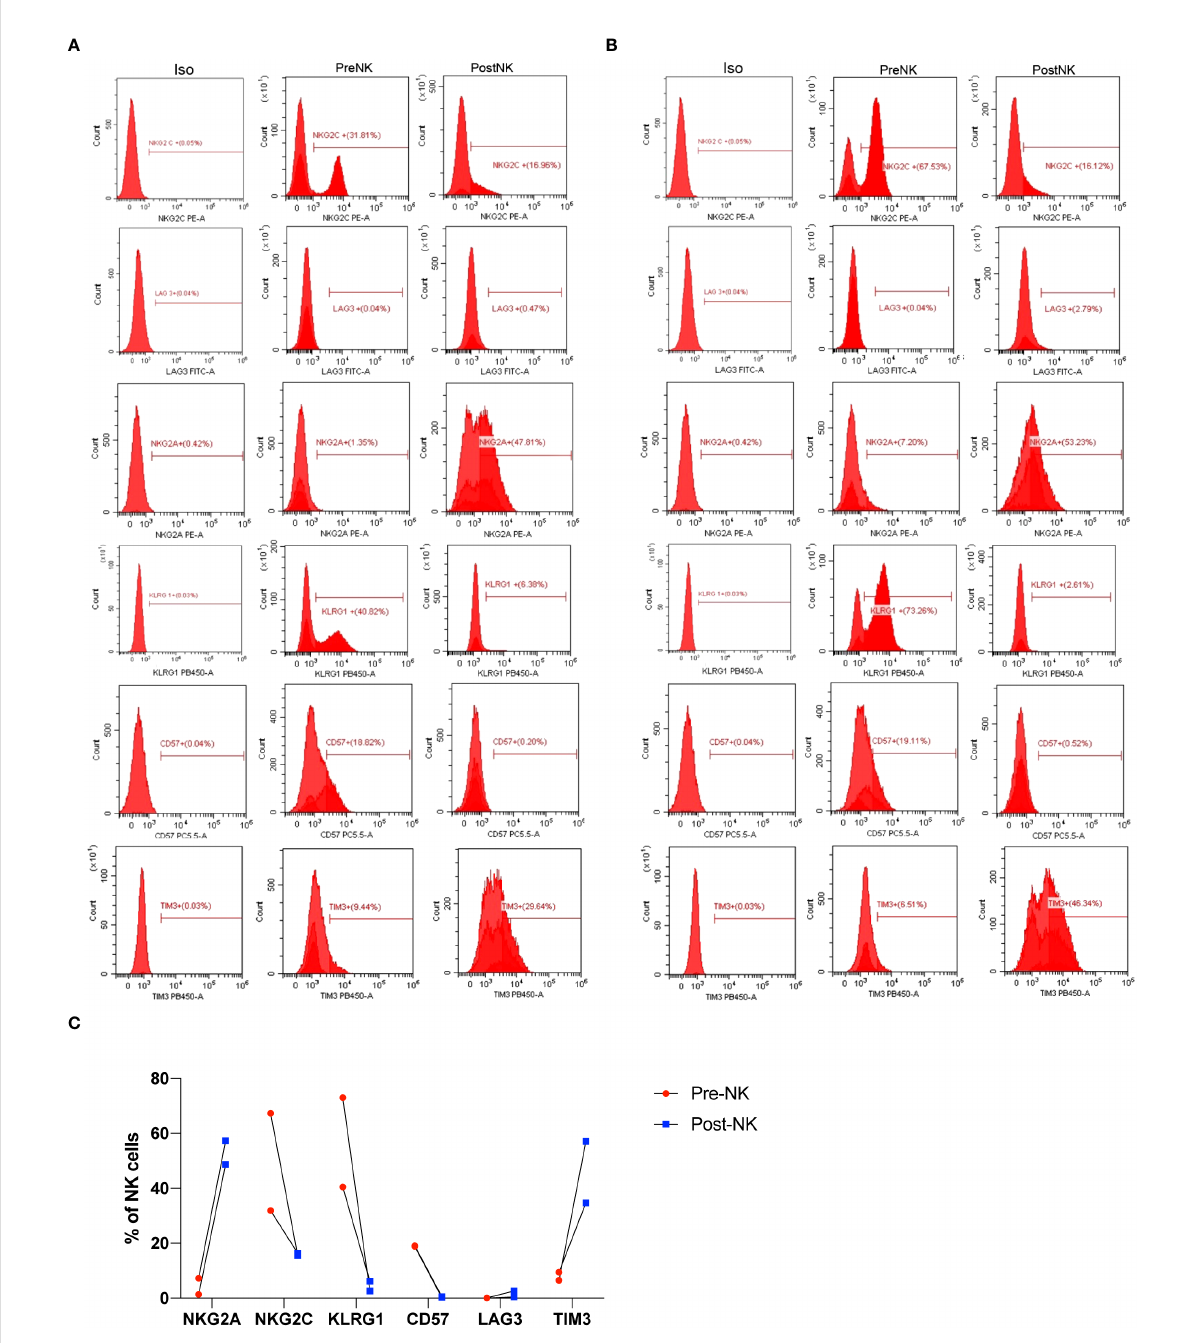
FIGURE 8 Phenotypic characterization of preNK and postNK cells. (A) preNK and postNK cells of donor 1 were used for fl ow cytometry analysis of NKG2A, NKG2C, LAG3, KLRG1, CD57, and TIM3. (B) preNK and postNK cells of donor 2 were used for fl ow cytometry analysis of NKG2A, NKG2C, LAG3, KLRG1, CD57, and TIM3. (C) The alteration trend of indicated